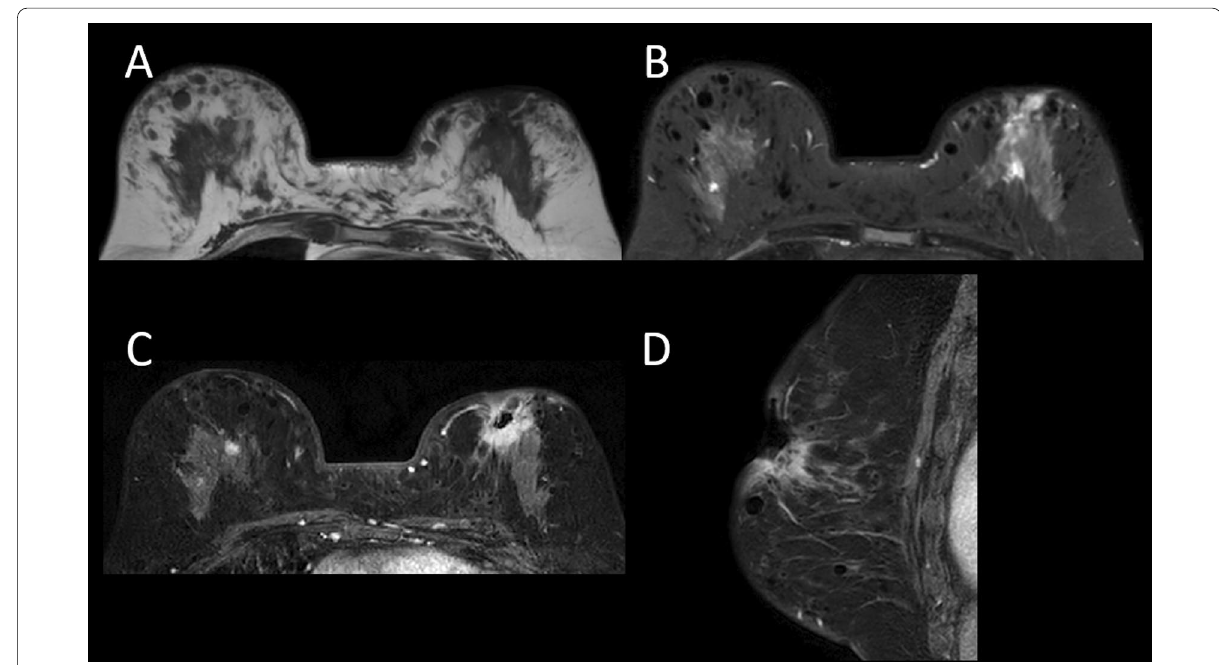
Fig. 2 Breast MRI. A Axial T1WI B Axial fat suppressed T2WI C Axial contrast enhanced T1WI. D Sagittal contrast enhanced T1WI. Breast MRI shows a large ulcerative lesion in the left breast (arrow). There is an irregular shaped enhancing mass on the base of the ulcer and it is continuous